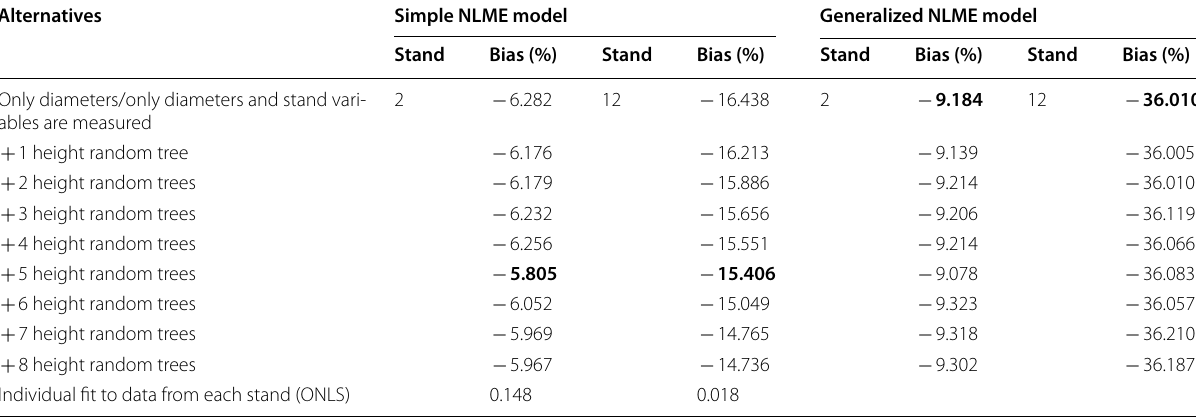
Bold, statistics of selected models